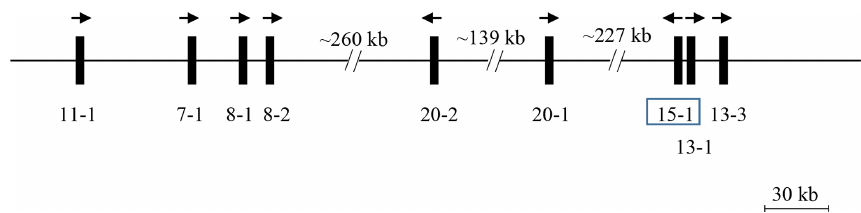
Figure 1. KAP genes identified on goat chromosome 1. The newly identified KRTAP15-1 is shown in the box, along with eight previously identified KRTAP s. Vertical bars represent KRTAP s, with the names of the genes being indicated below (i.e. 11-1 represents KRTAP11-1 ). The arrows represent the direction of transcription. The distances between these genes are approximate and refer to the caprine genome assembly NC_030808.1.